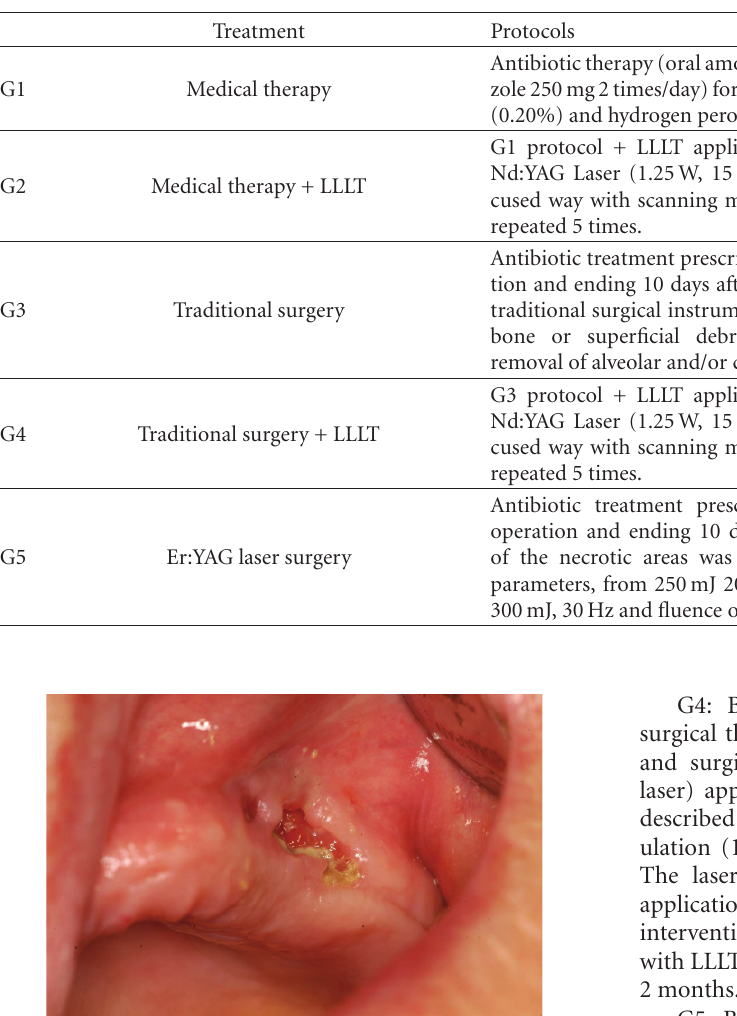
Table 3: Protocols used for di ff erent therapeutical approaches.